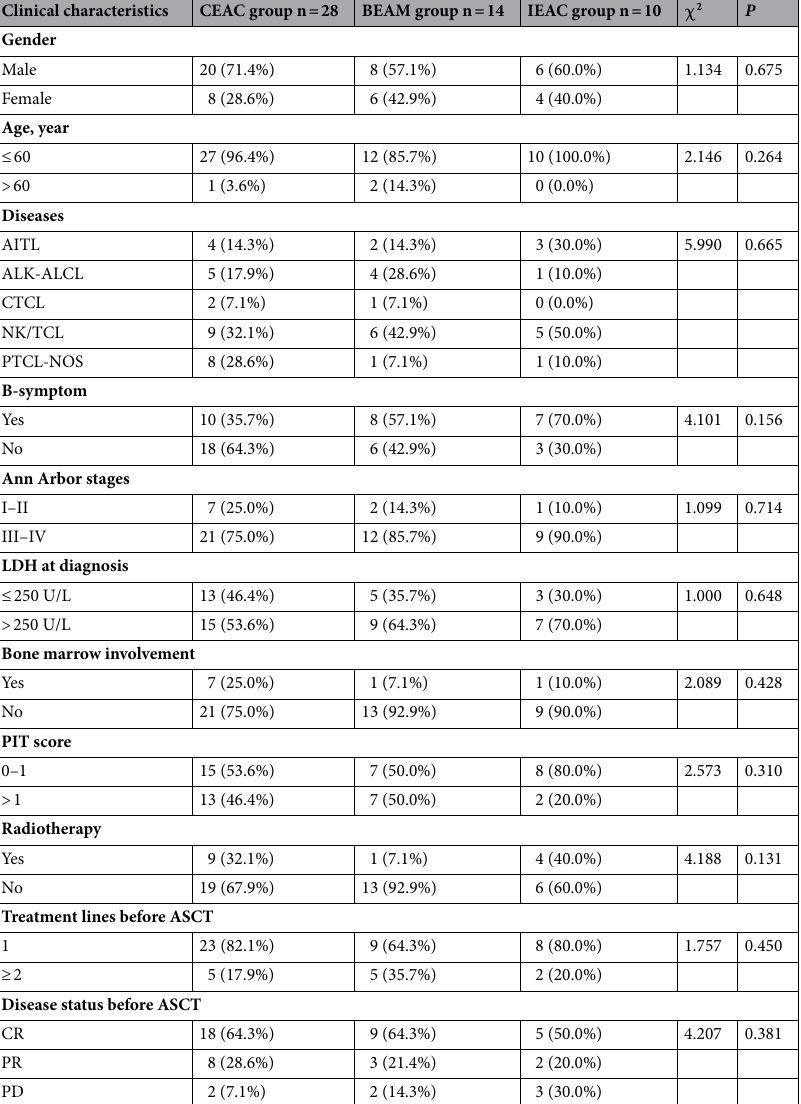
Table 1. Clinical characteristics of 52 patients with PTCL in CEAC, BEAM and IEAC groups. AITL, angioimmunoblastic T-cell lymphoma; ALK-ALCL, anaplastic lymphoma kinase negative anaplastic cell lymphoma; CTCL, cutaneous T-cell lymphoma; NK/TCL, natural killer/T cell lymphoma; PTCL-NOS, peripheral T-cell lymphoma, not otherwise specified; LDH, lactate dehydrogenase; PIT, the T cell lymphoma prognostic index; ASCT, autologous stem cell transplantation; CR, complete response; PR, partial response; PD, progressive